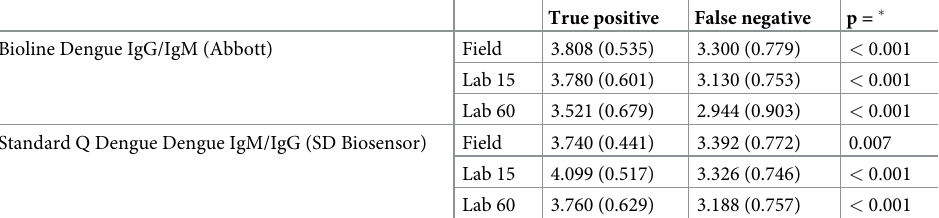
Table 3. Comparison of mean reference ELISA index values (IVs) between individuals who had true positive vs. false negative rapid diagnostic tests (RDTs) under differing test conditions. True positive